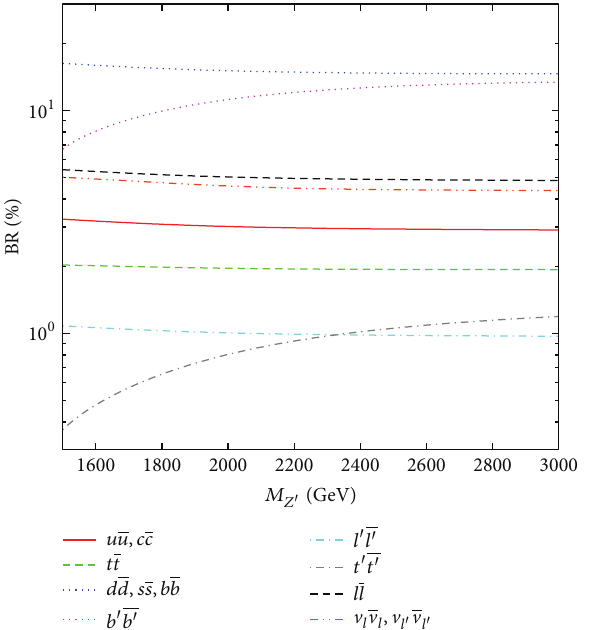
Figure 4: Branching ratios (%) depending on the mass of 𝑍 󸀠 boson for diagonal couplings to quarks and leptons within the 𝑍 󸀠 𝜒 model. Thenewheavyquarkmassesaretakentobe700 GeV,andnewheavy charged lepton mass is 200 GeV and new heavy neutrino mass is 100GeV.